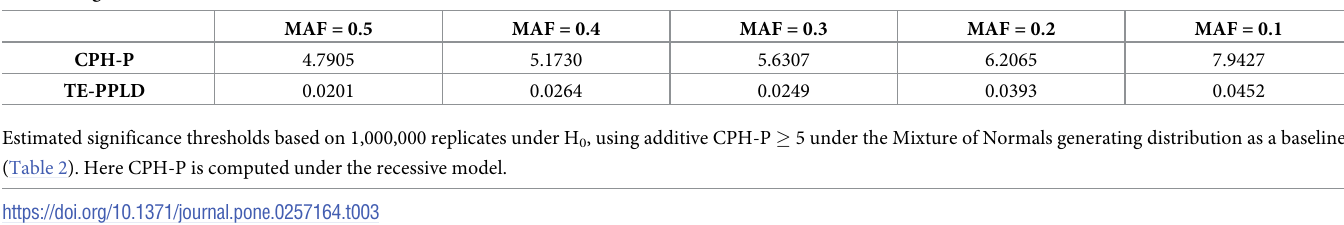
Table 3. Significance thresholds as a function of